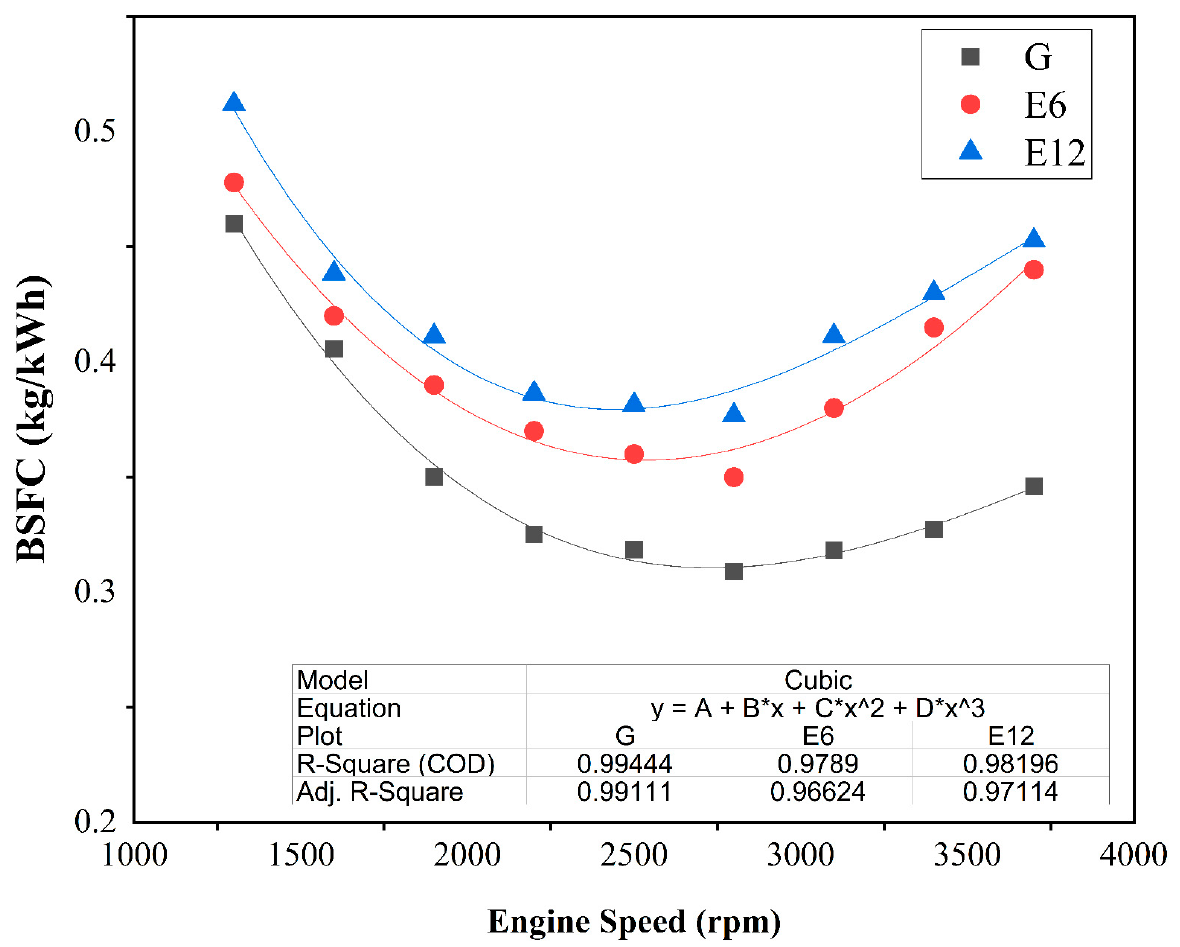
Figure 4. BSFC variation with engine speed.